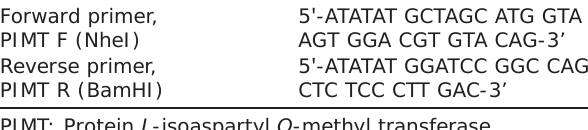
Table-1: Designed primers of PIMT of S. enterica subsp. enterica serovar Typhimurium. Forward primer, PIMT F